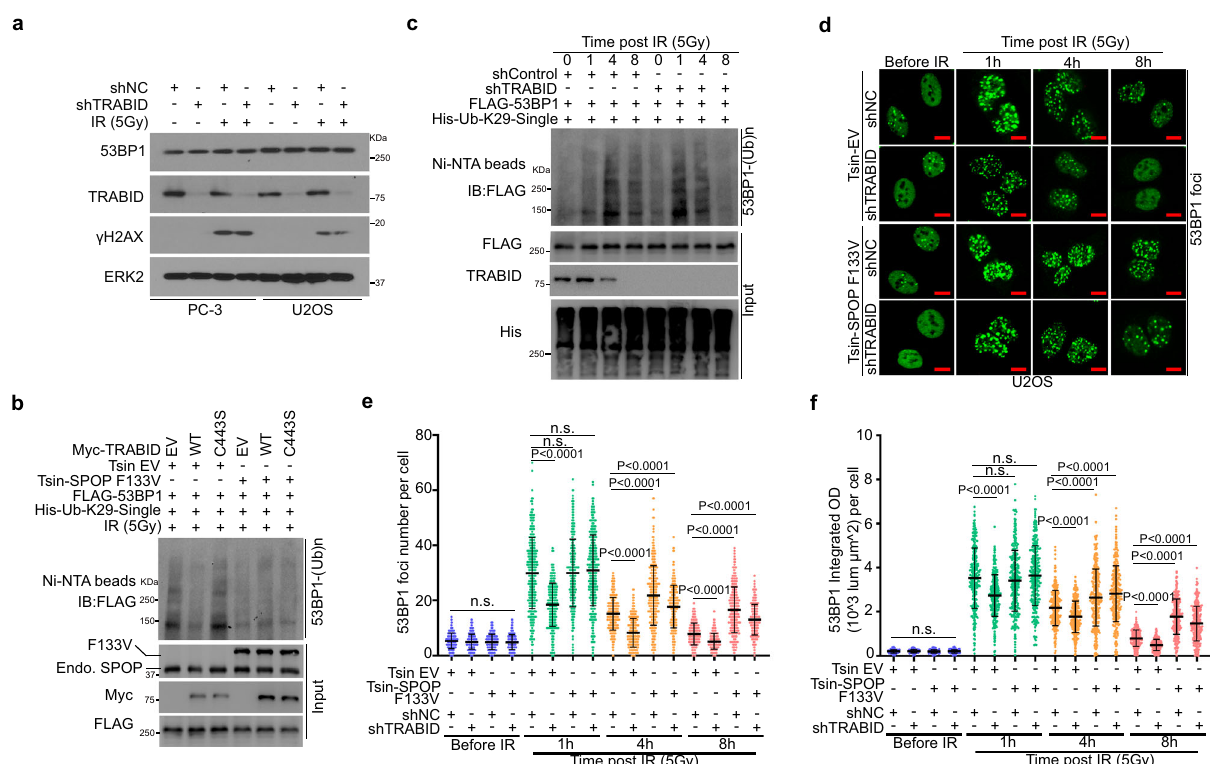
Fig. 3 | TRABID antagonizes SPOP-mediated removal of 53BP1 from DSB via deubiquitination of 53BP1. a PC-3 and U2OS cells infected with lentivirus expressing indicated shRNAs were treated with IR for 1h and harvested for WB analysis. b Ubiquitination assay using Ni-NTA pull-down in 293T cells transfected with His-K29-single ubiquitin together with other indicated plasmids and treated withIR(5Gy)for1h. c UbiquitinationassayusingNi-NTApull-downin293Tcontrol and TRABID knockdown cells transfected with indicated plasmids. Cells were har- vested at different time points after IR. d – f U2OS cells infected with lentivirus expressing indicated shRNA were treated with IR followed by IFC of 53BP1 at the